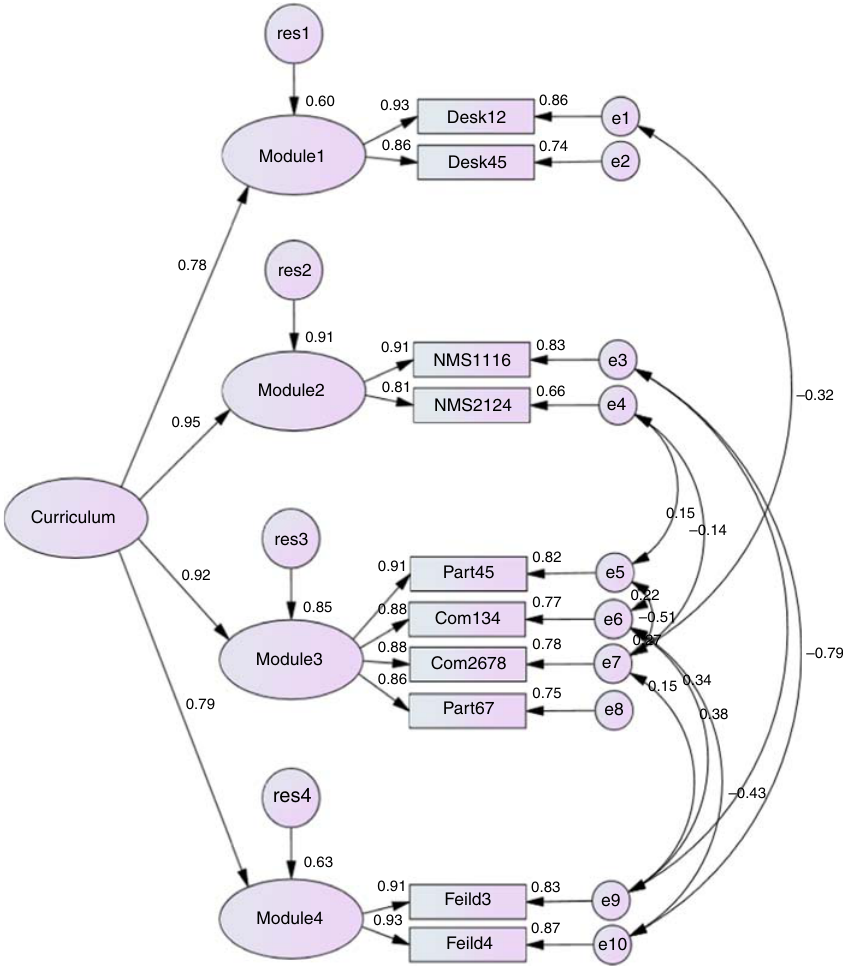
Figure 1. The second-order CFA model of the training program factors to develop the competency of ROO in the VSPO in